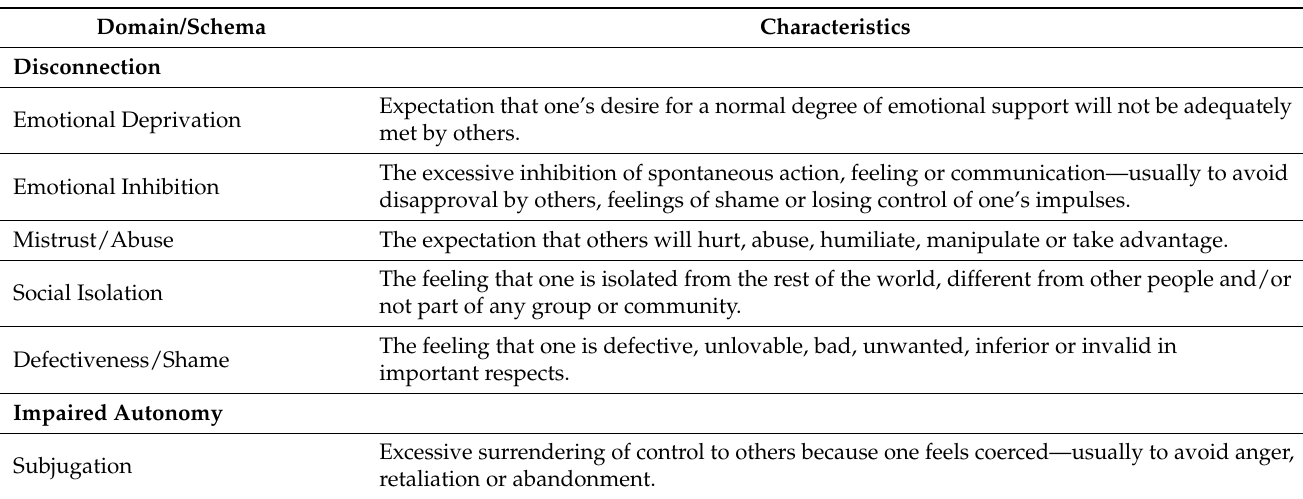
Table 1. Characteristics of early maladaptive schemas (EMS), see: Young et al., 2003 [22]. Domain/Schema